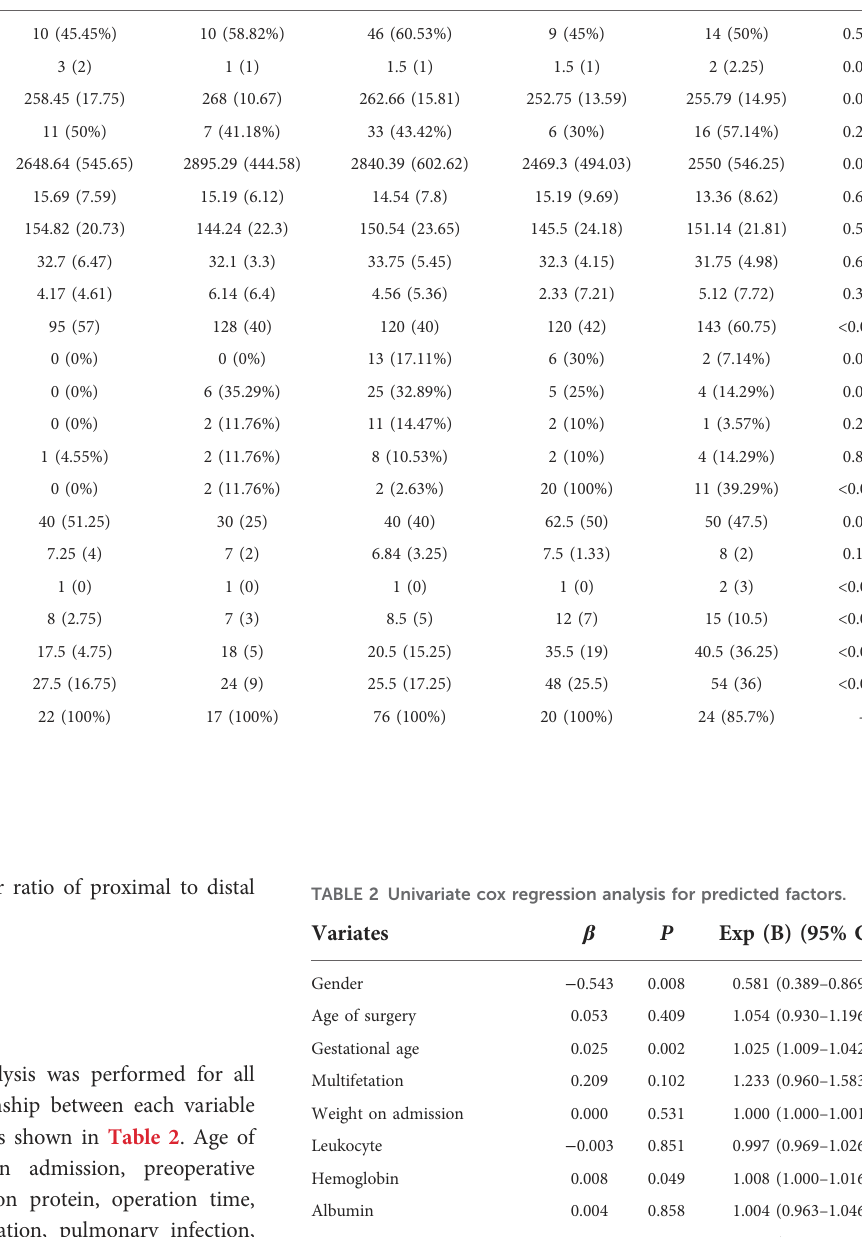
TABLE 1 General information of neonates with intestinal atresia after primary anastomosis. Variates